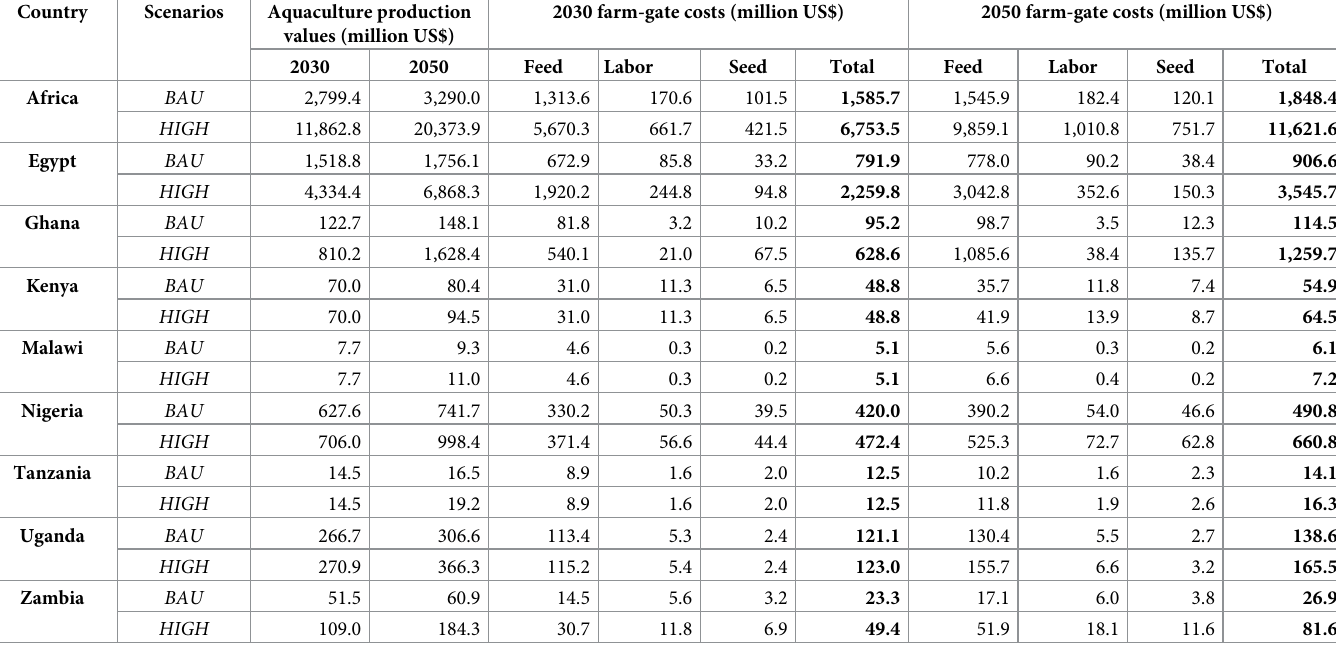
Table 7. Annual output value and key inputs costs of Africa’s aquaculture for BAU and HIGH scenarios in 2030 and 2050. Country